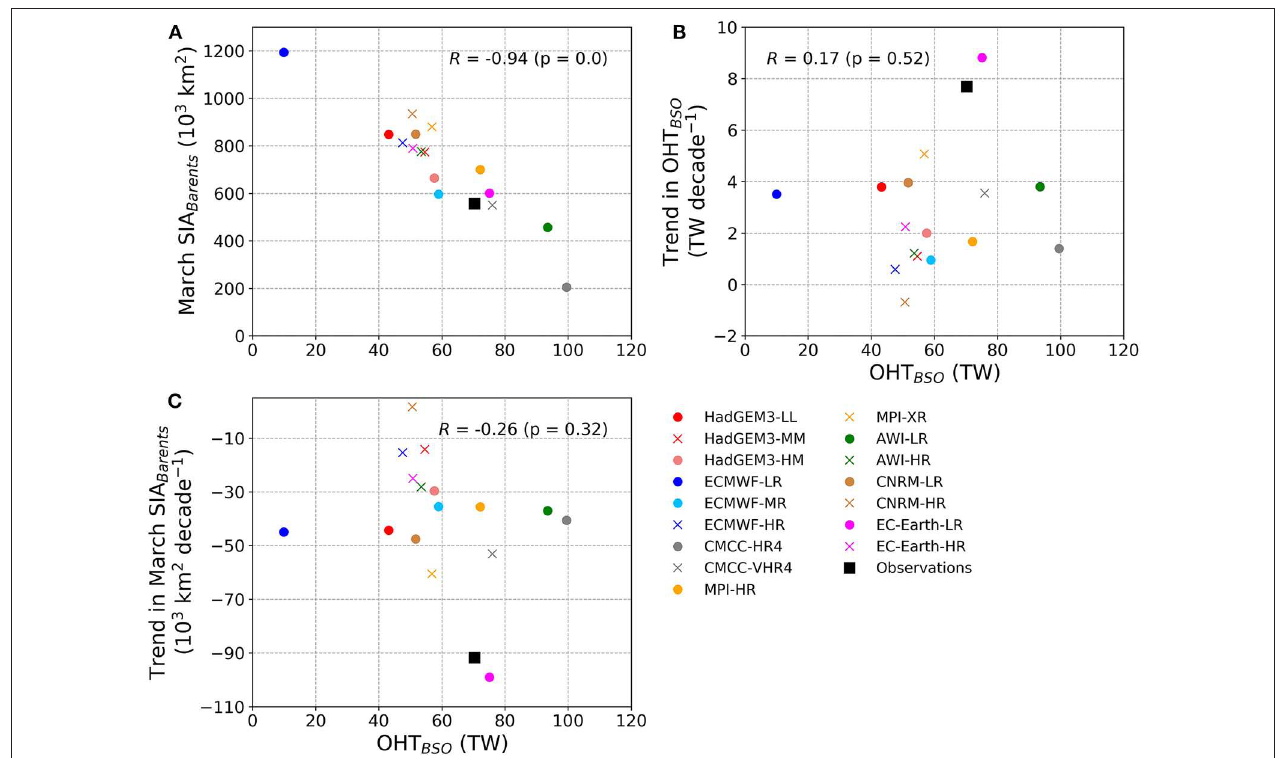
FIGURE 8 | Scatter plots of (A) mean March Barents sea-ice area (SIA Barents ), (B) trend in ocean heat transport (OHT) at the Barents Sea Opening (BSO, large transect), and (C) trend in March Barents sea-ice area against mean OHT at the BSO (large transect) for all HighResMIP hist-1950 model outputs (averaged over 1950–2014) and observations/reanalysis. Observed sea-ice area is averaged over 1979–2014 and ORA-IP reanalysis for OHT is averaged over 1993–2010. Correlation coefficients R (with their p -value) are indicated in the upper left/right corner of each